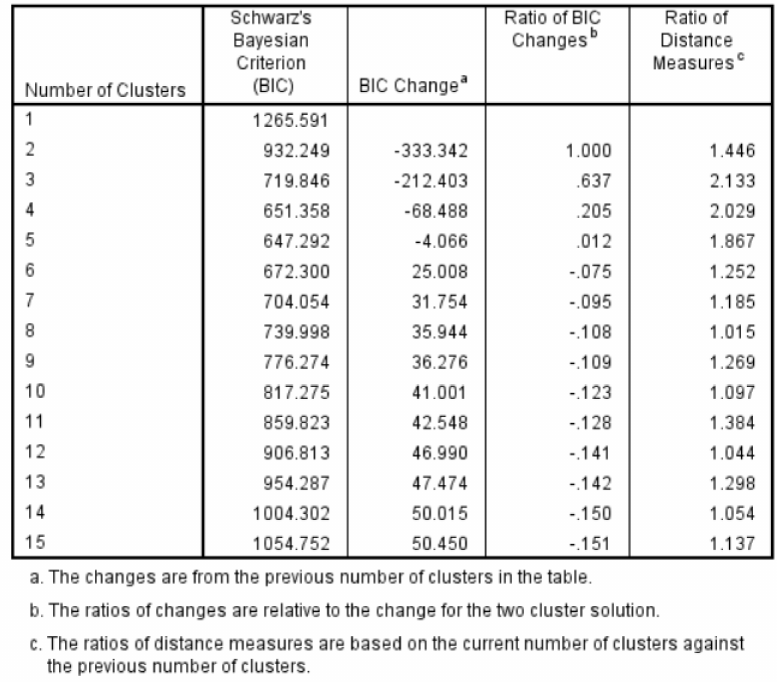
Figure A1. BIC for auto-clustering.